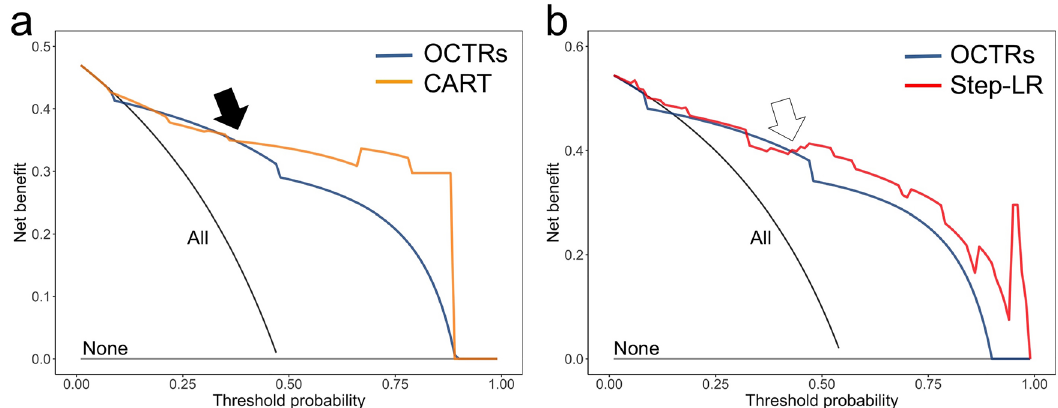
Figure 6. Decision curve analysis (DCA) of the final models and conclusions of the on-call teleradiologists (OCTRs) in the validation cohort, depending on data on which they were trained: ( a ) radiological and ( b ) clinical + radiological. The x-axis corresponds to the odds or risk threshold at which a patient would opt for COVID-19 management. The y-axis corresponds to the overall net benefit. The black line represents the ‘treat all’ patients COVID-19 strategy. The grey horizontal line represents the ‘treat none’ of the patients strategy. For both sources of data, the added value of the models over the ‘treat all’ strategy and the OCTRs readings are highlighted for risk thresholds above 0.43 (arrows). CART classification and regression tree, Step-LR stepwise logistic